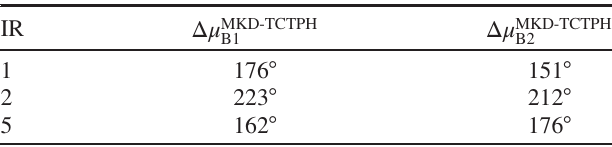
TABLE III. 2018 208 Pb 82 þ ion run optics Δ μ MKD-TCT summary for B1 and